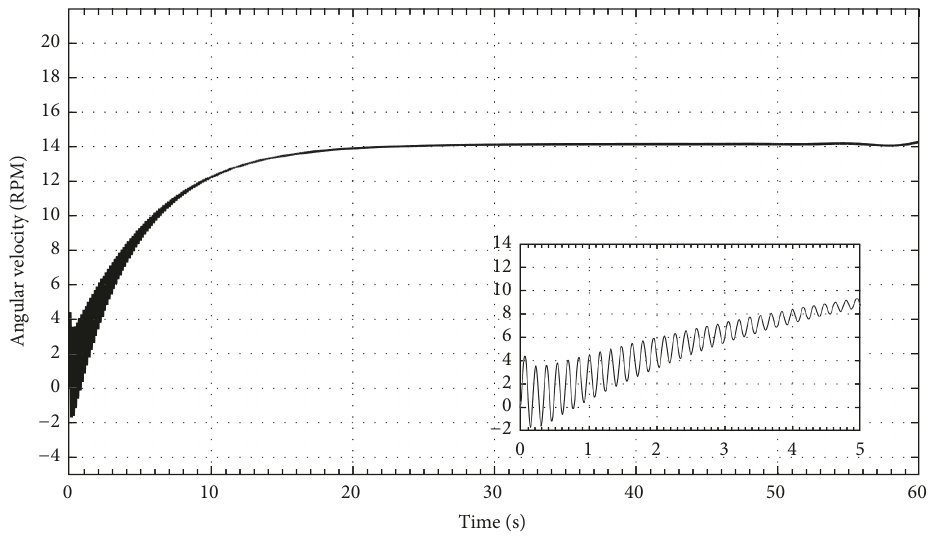
Figure 6: Rotor-blade rotational speed.